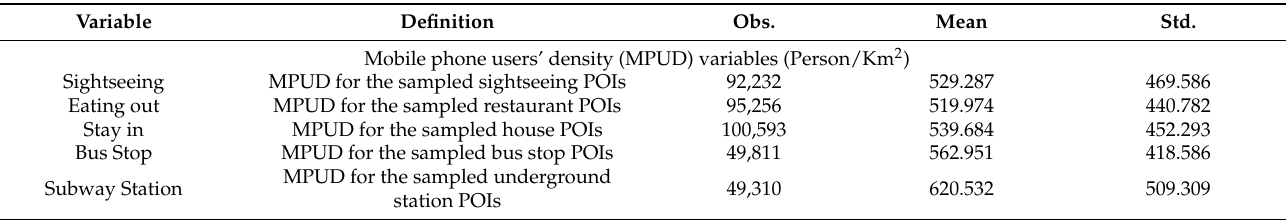
Table 5. Variable definitions and summary